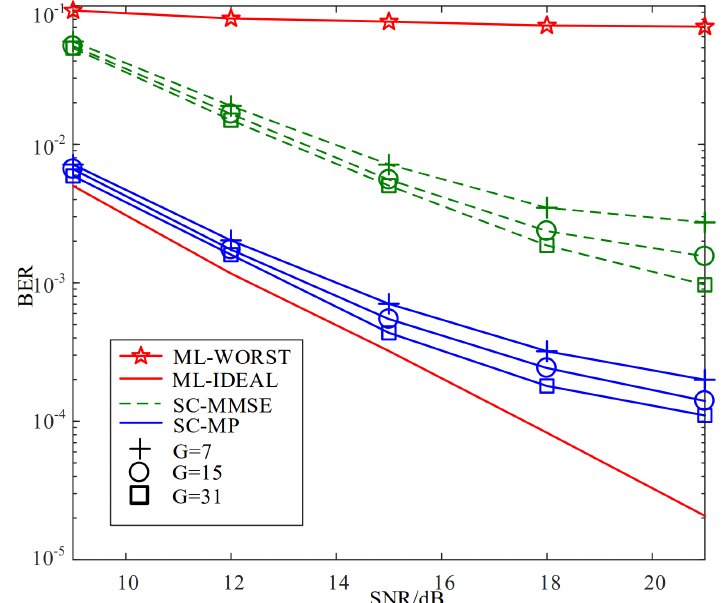
Figure 6. BER comparisons of the proposed SC-MMSE and SC-MP detectors for the GSTFIM systems with different numbers of effective subcarriers G in three